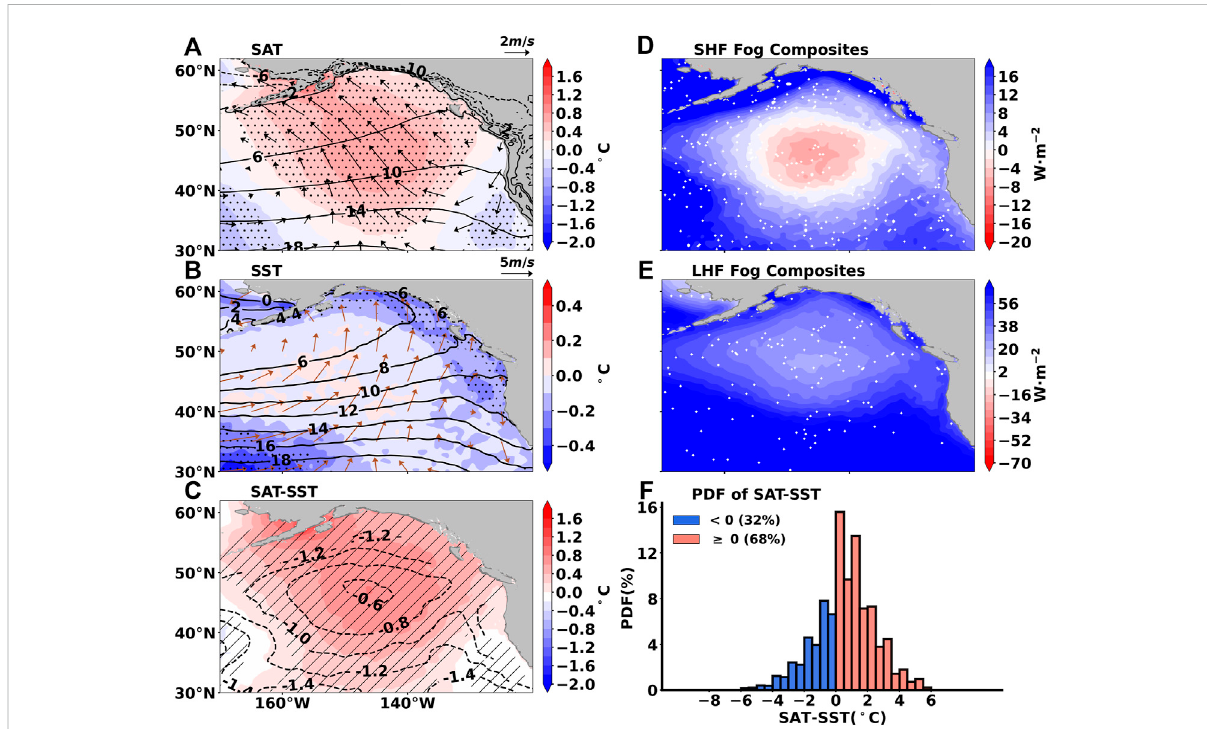
FIGURE 4 Air and ocean properties of the NEP fog. (A) Surface horizontal wind anomaly (vectors, m · s − 1 ), climatological mean SAT (black contour, ° C), and SAT anomaly (shaded, ° C);the black dots denote that the SATanomaly issigni fi cant at the95% con fi dence level. (B) Surface horizontal wind with fog (vectors, m · s − 1 ), climatological SST (black contour, ° C), and SST anomaly (shaded, ° C); the black dots indicate the SST anomaly signi fi cant at the 95% con fi dence level. (C) Climatological SAT – SST (black dashed contour, ° C) and SAT – SST anomaly (shaded, ° C); the shade lines indicate